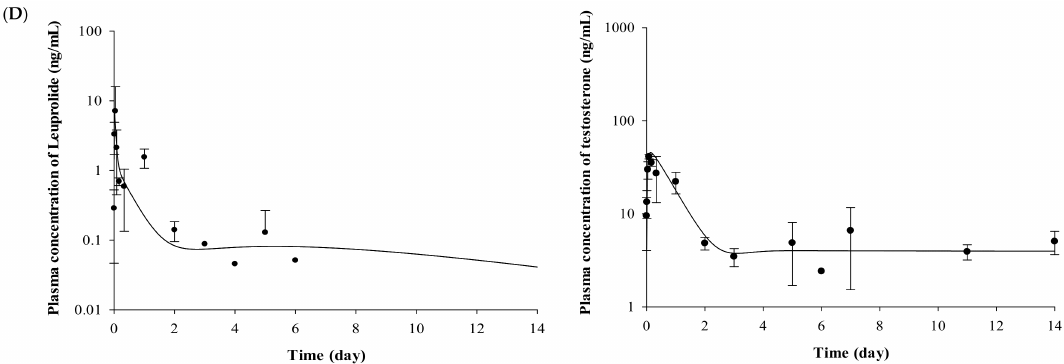
Figure 2. Mean observed concentration and fitted line of leuprolide and testosterone after ( A ) IV administration of leuprolide solution, ( B ) SC administration of leuprolide solution, ( C ) SR depot in normal Wistar rat, and ( D ) SR depot in Iar:COP rat using developed PK–PD model ( n = 5). Closed circles indicate the observed leuprolide or testosterone levels in plasma. Solid lines mean the fitted line of leuprolide or testosterone by using developed PK–PD